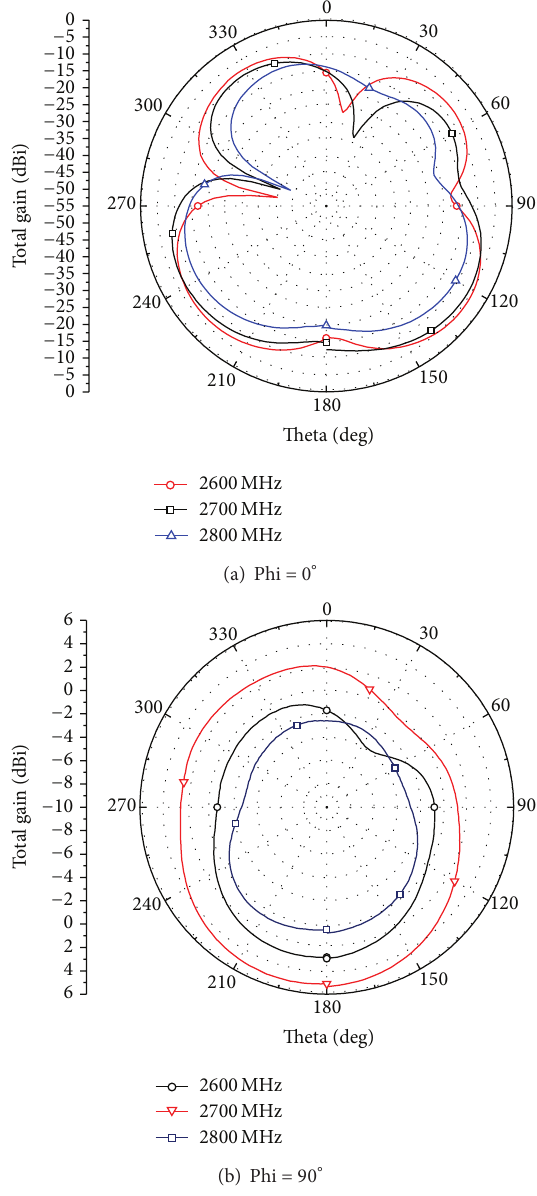
Figure 10: Measured radiation patterns of the proposed